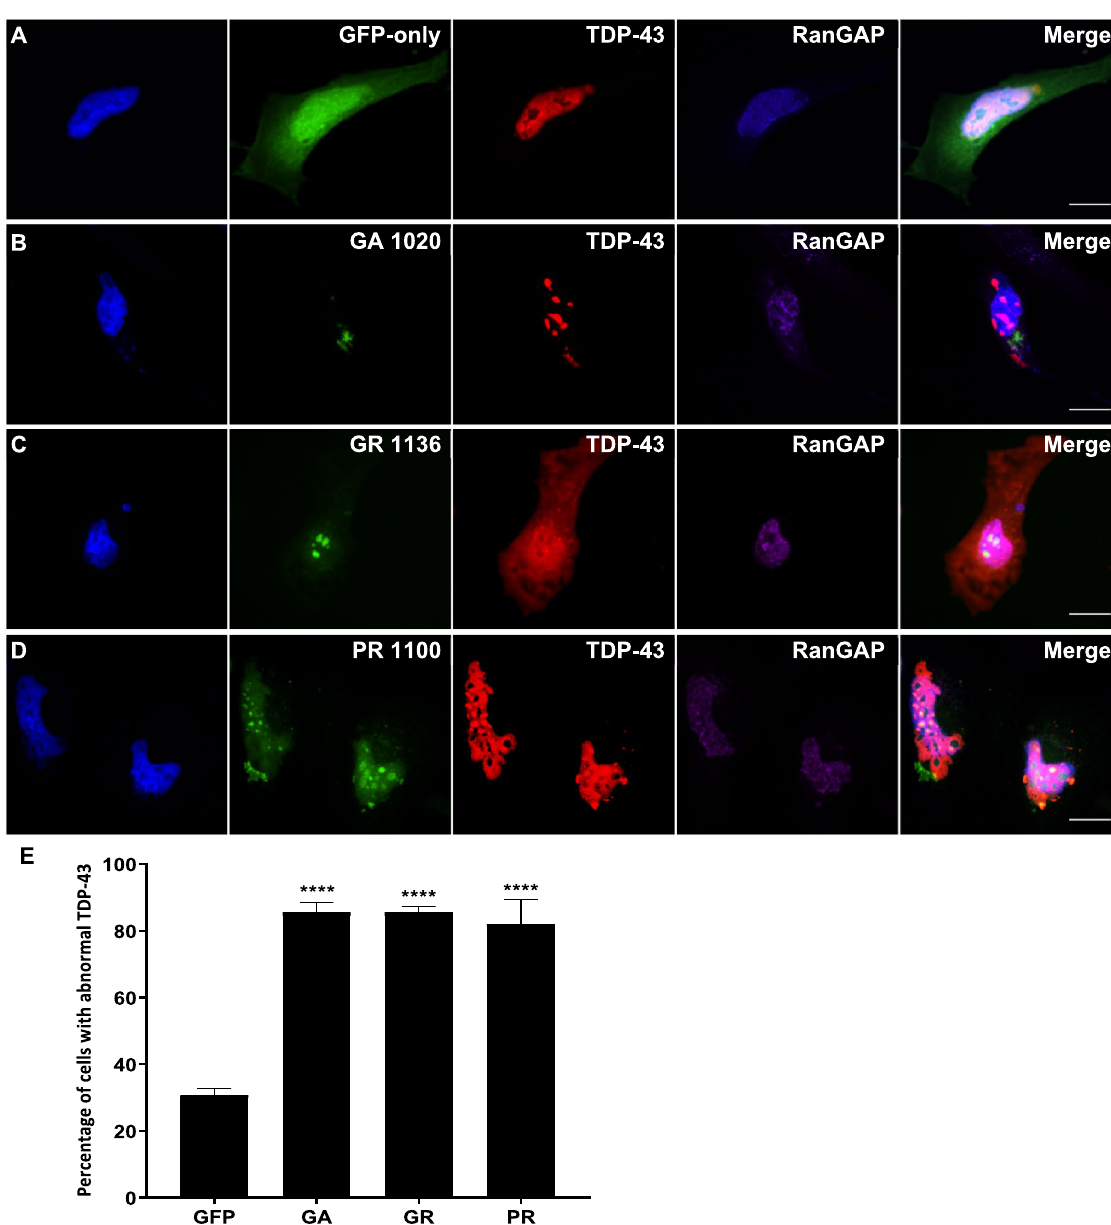
Figure 5. DPR-induced mislocalisation of TDP-43 and Ran occur together. ( A – D ) HeLa cells co-transfected with mCherry-tagged human TDP-43 (red) and GFP-tagged DPR constructs or empty pEGFP-N1 vector as a GFP-only control were fixed and stained 48 h post-transfection. Ran was stained using a Cy5-conjugated antibody (purple). Cells exhibiting DPR-induced TDP-43 mislocalisation typically also exhibited mislocalisation of Ran to the cytoplasm. Scale bars indicate 15 μm. ( E ) The mean percentage of cells with abnormal TDP-43 that also exhibited abnormal Ran localisation was significantly increased by GA 1020 ( P = 0.0044) , GR 1136 ( P < 0.0003), and PR 1100 ( P = 0.0009). n = 3, with a minimum of 30 cells analysed for each independent replicate. Data was analysed by one-way ANOVA with Dunnett’s multiple comparison test. Error bars indicate